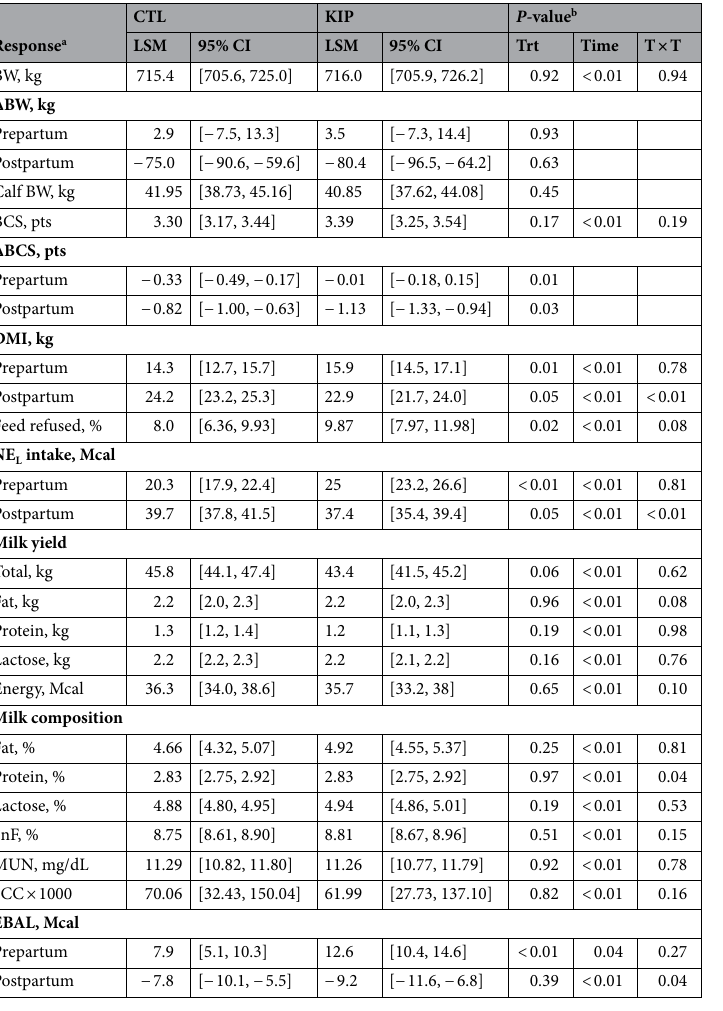
Table 1. Least squares means (LSM) and 95% confidence intervals (CI) of body weight, body condition score, dry matter intake, milk and milk component yield, milk composition, and energy balance for cows exposed to a control (CTL) or ketosis induction protocol (KIP) treatment. a Body weight = BW, BW change = ΔBW, body condition score = BCS, prepartum changes are from − 28 to + 1 expected days relative to calving (DRTC) and postpartum are from + 1 to + 56 DRTC, solids not fat = SnF, milk urea nitrogen = MUN, somatic cell count (SCC; cells/mL × 1000); net energy of lactation (NE L ) intake, milk energy and energy balance (EBAL) were based on published equations (NRC, 2001). b Statistics for fixed effects are treatment (TRT), time (week), and the interaction of TRT and time (T ×